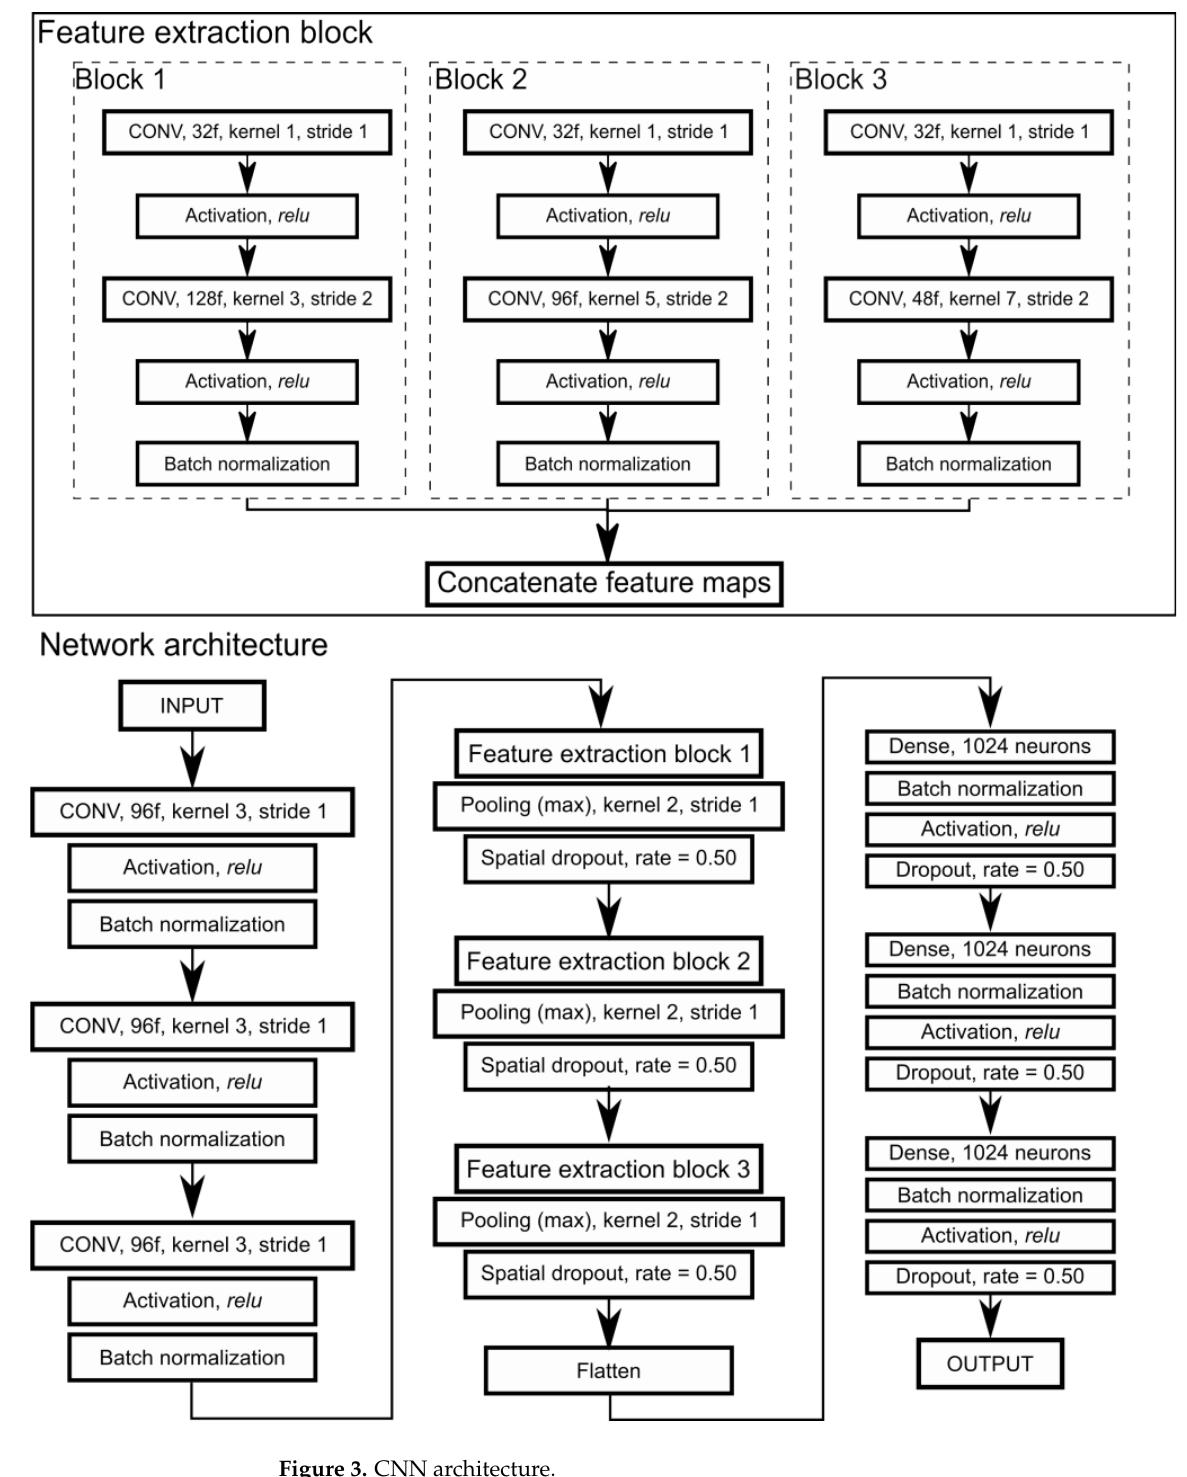
Figure 3. CNN architecture.